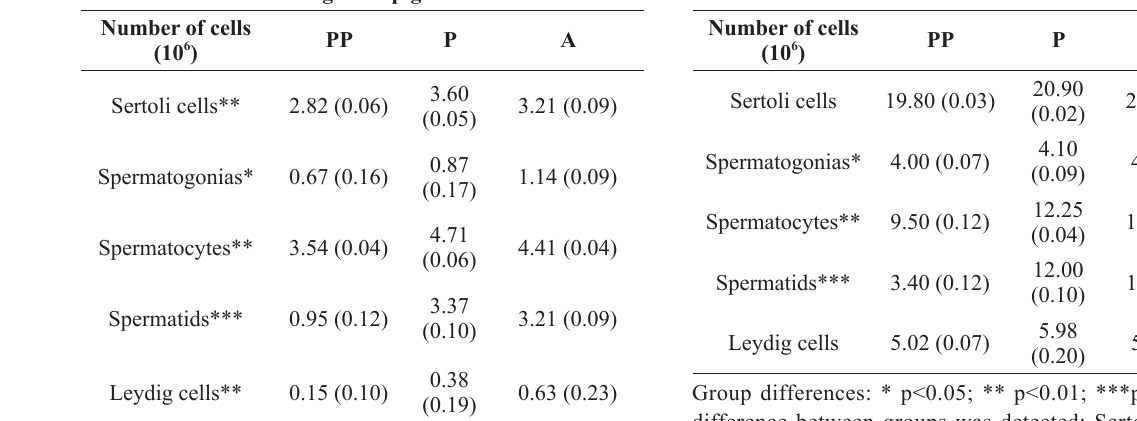
difference between groups was detected: Sertoli cells and Leydig